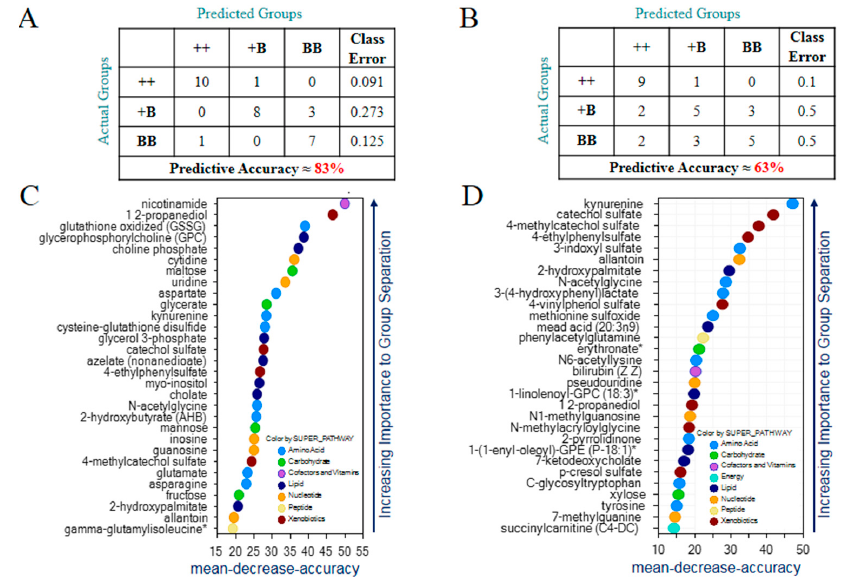
Figure 3. Identification of biomarkers for the FecB effect in FF and OVS samples. ( A ) Random forest classification in FF of BB compared to +B and ++ gave a predictive accuracy of 83%. ( B ) Random forest classification in OVS of BB compared to +B and ++ gave a predictive accuracy of 63%. ( C ) Important biochemicals identified in FF samples. ( D ) Important biochemicals identified in OVS samples.